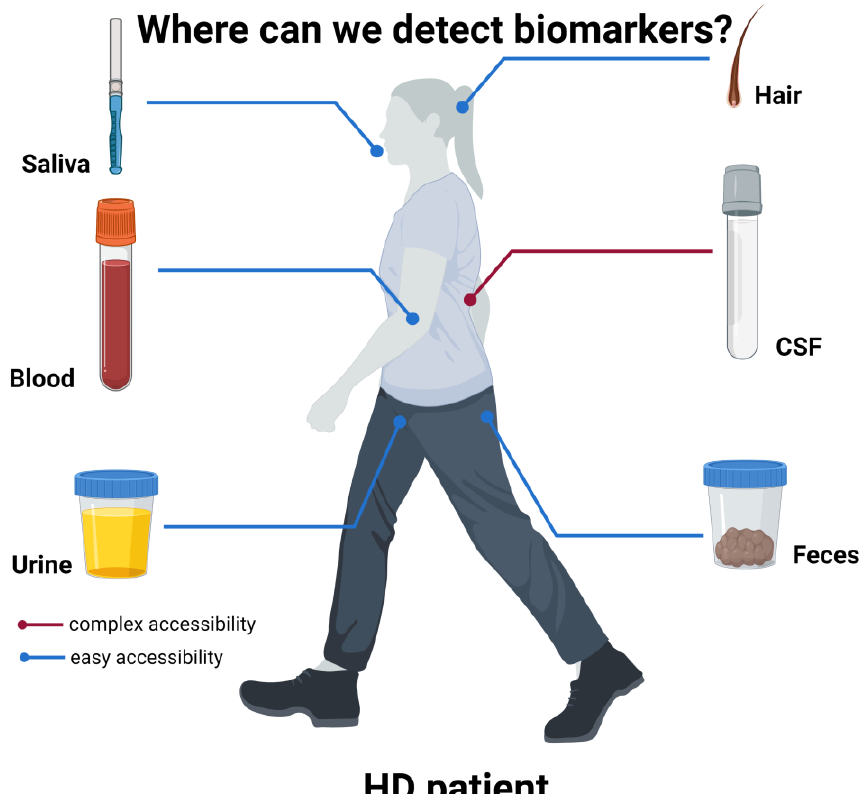
Figure 1. Biomarkers sources in HD patients.